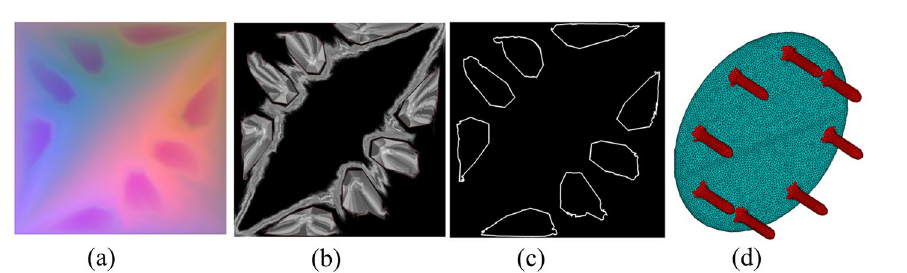
Figure 2. 3D mesh segmentation using